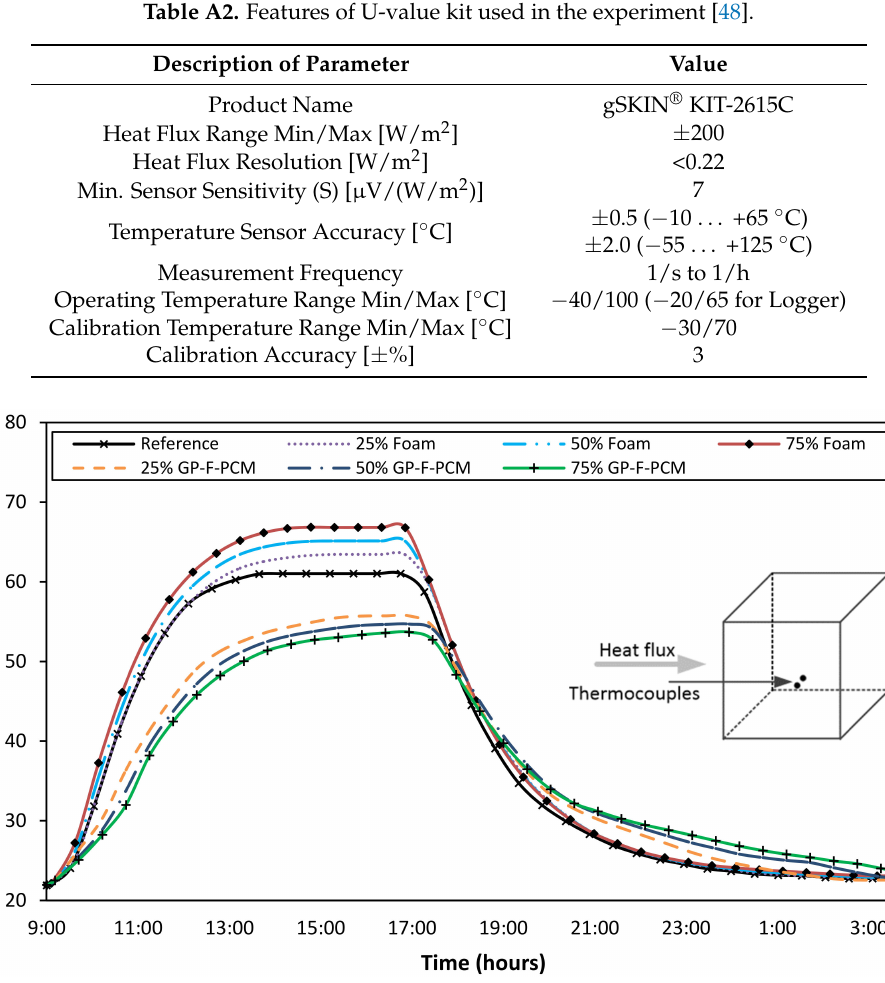
Figure A1. Comparison of temperature variations at the 2nd side of all the